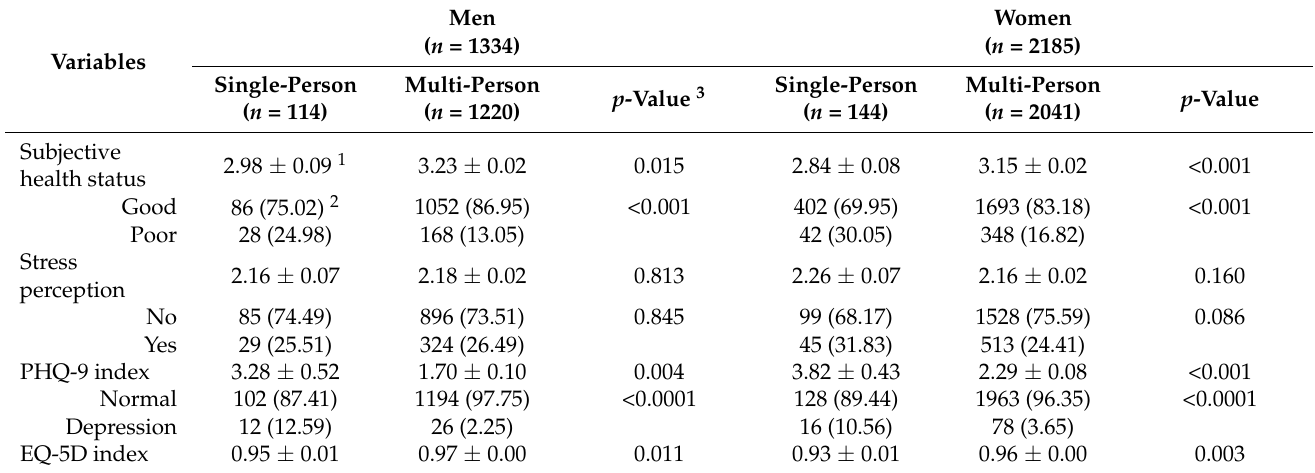
Table 2. Participants’ mental health status according to household size by